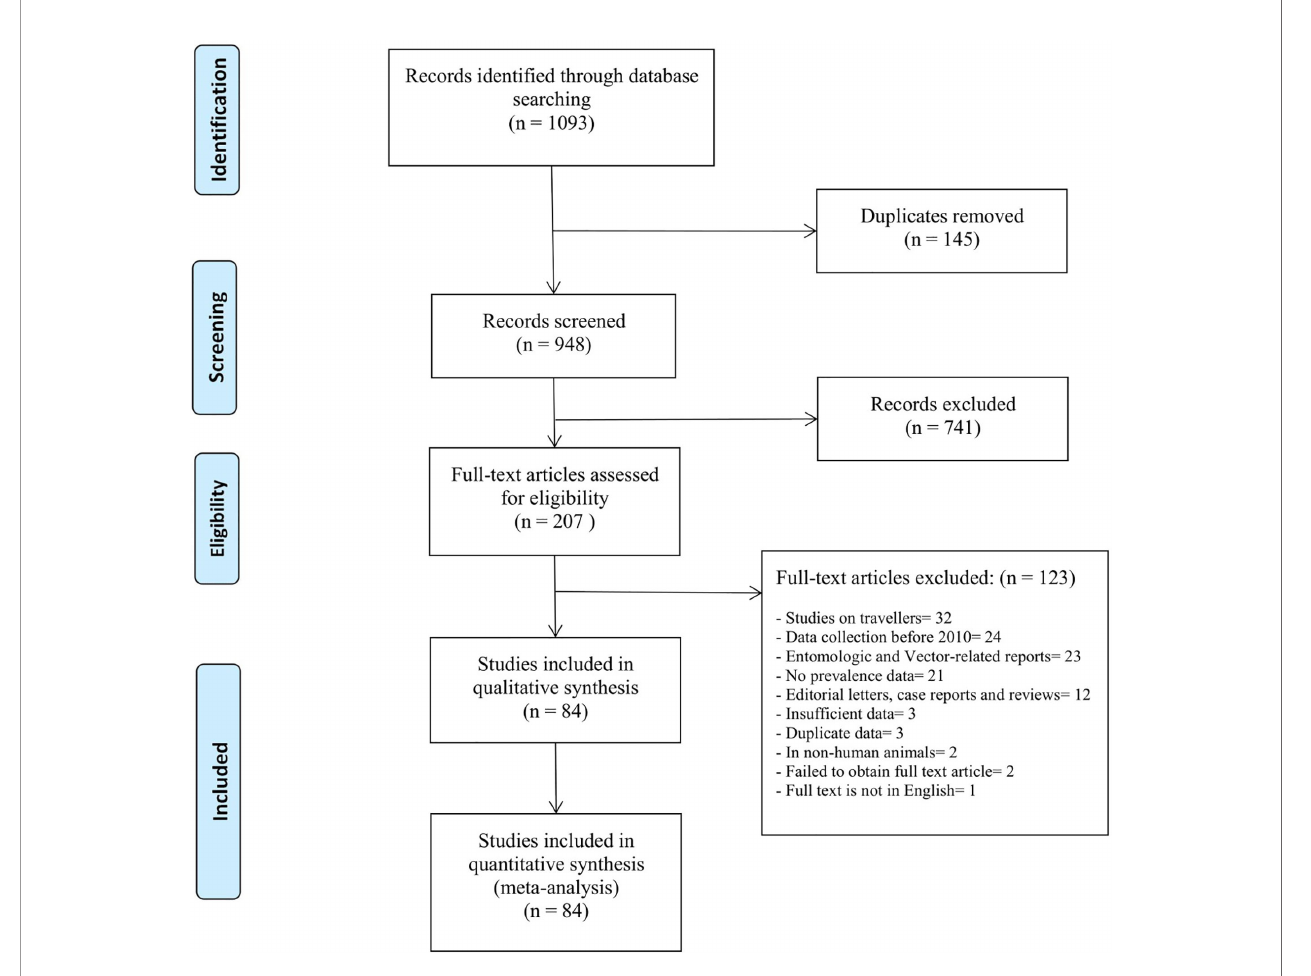
FIGURE 1 | PRISMA fl ow-chart outlines the identi fi cation, screening and selection of eligible studies.